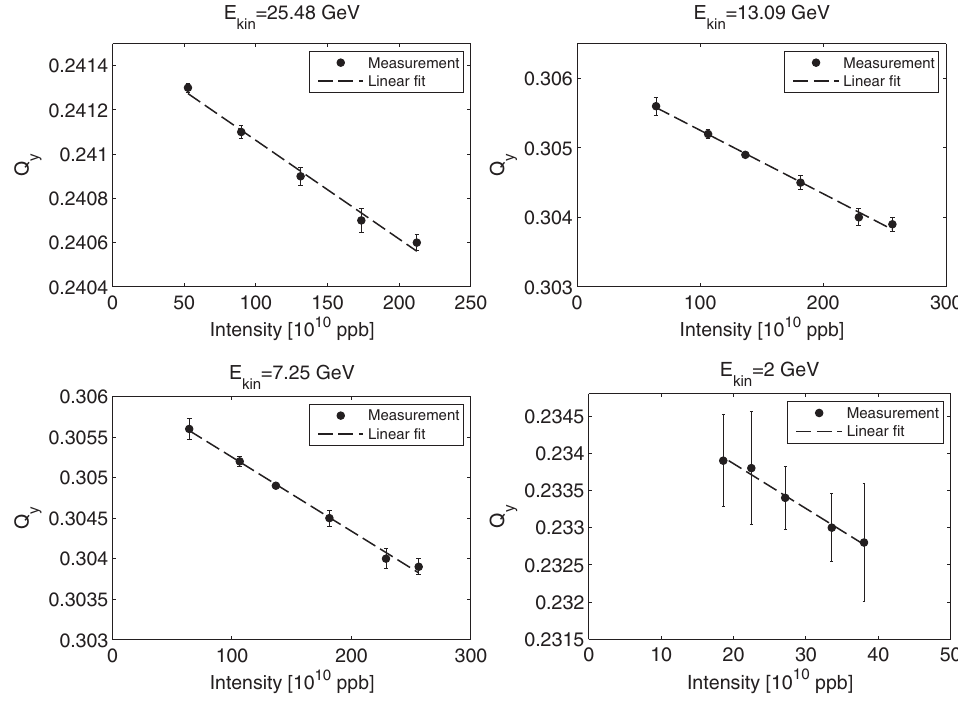
FIG. 3. Vertical tune shifts with beam intensity measured at different energies and the vertical chromaticity set to a value as close as possible to zero.